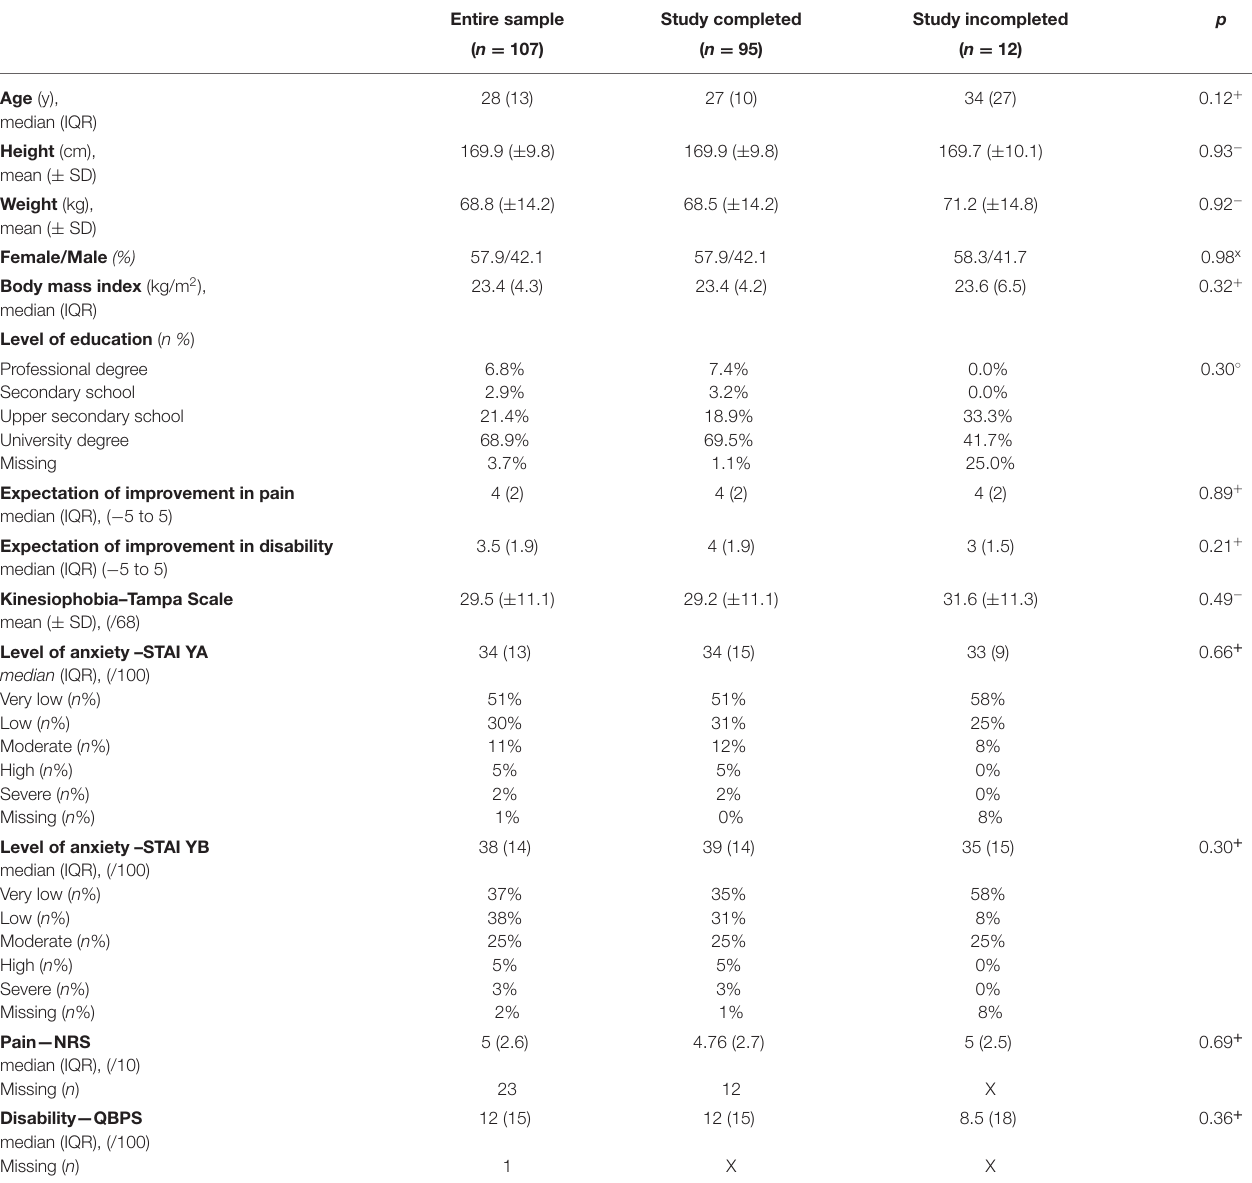
TABLE 1 | Baseline characteristics of the entire